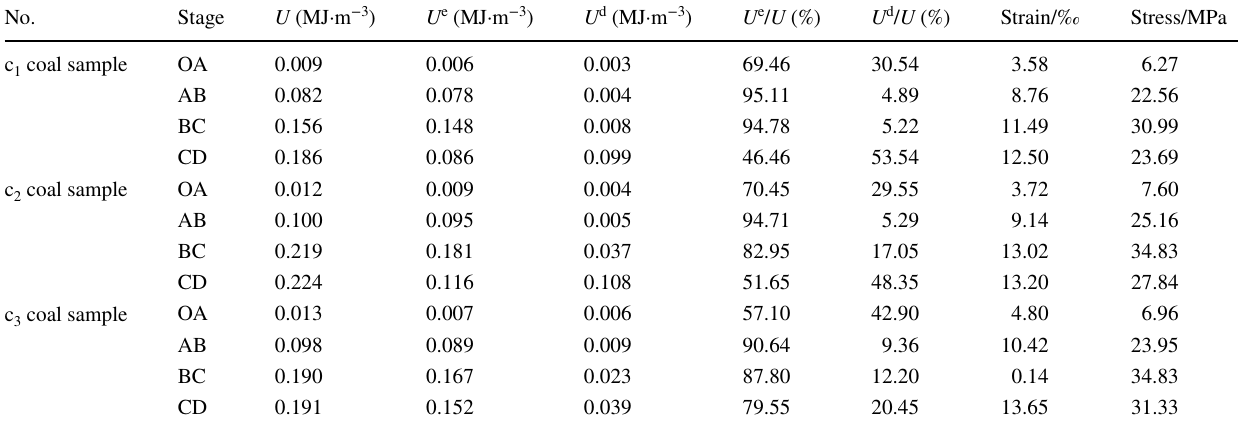
Fig. 6 Complete stress–strain-energy curve of raw coal sample under uniaxial compression Table 2 Energy parameters of each coal sample at each stage